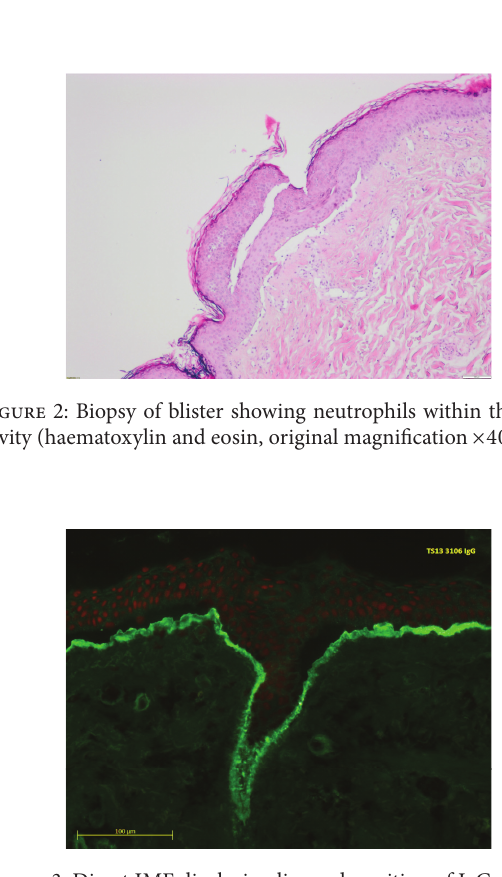
Figure 1: Midoesophageal endoscopic image showing superficial ulceration.